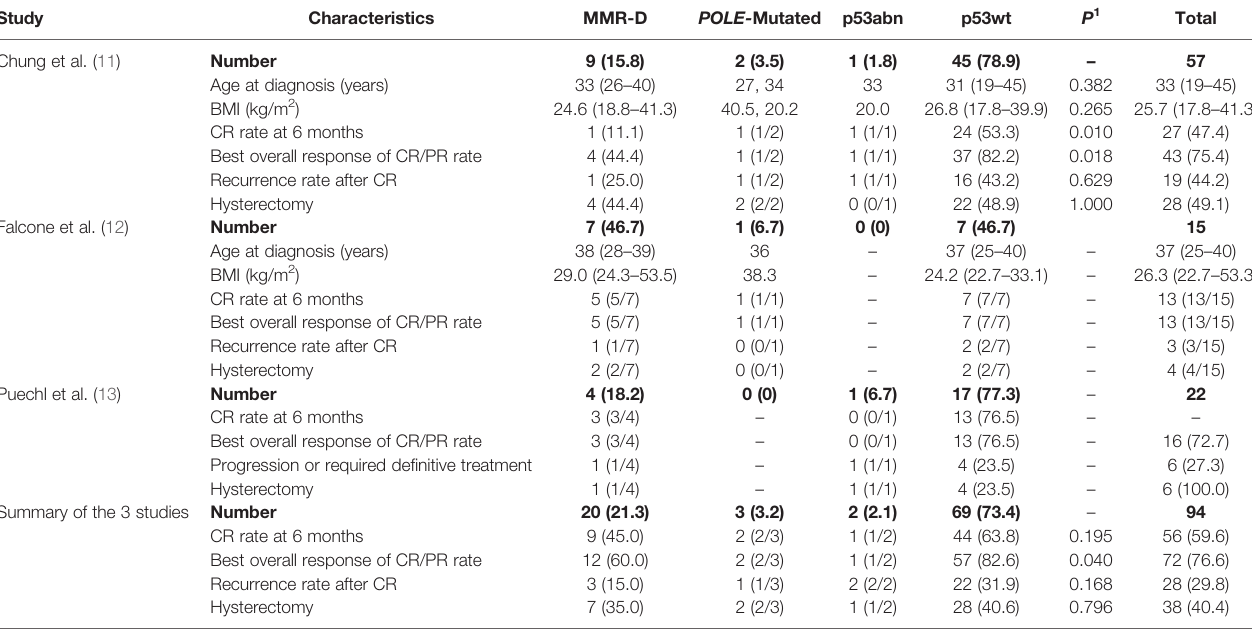
TABLE 1 | Molecular characterization of patients with endometrial cancer underwent FPT and